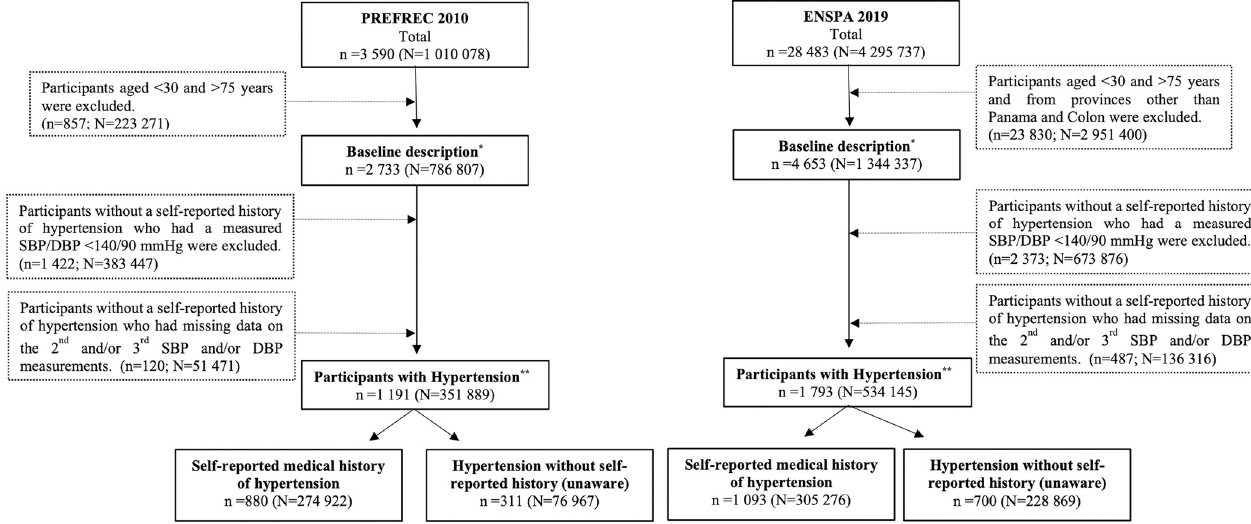
Fig 1. Flow chart of selected participants. SBP = systolic blood pressure. DBP = diastolic blood pressure. � Denominator for the prevalence of hypertension. �� Numerator for the prevalence of hypertension and the denominator for the prevalence of hypertension unawareness.